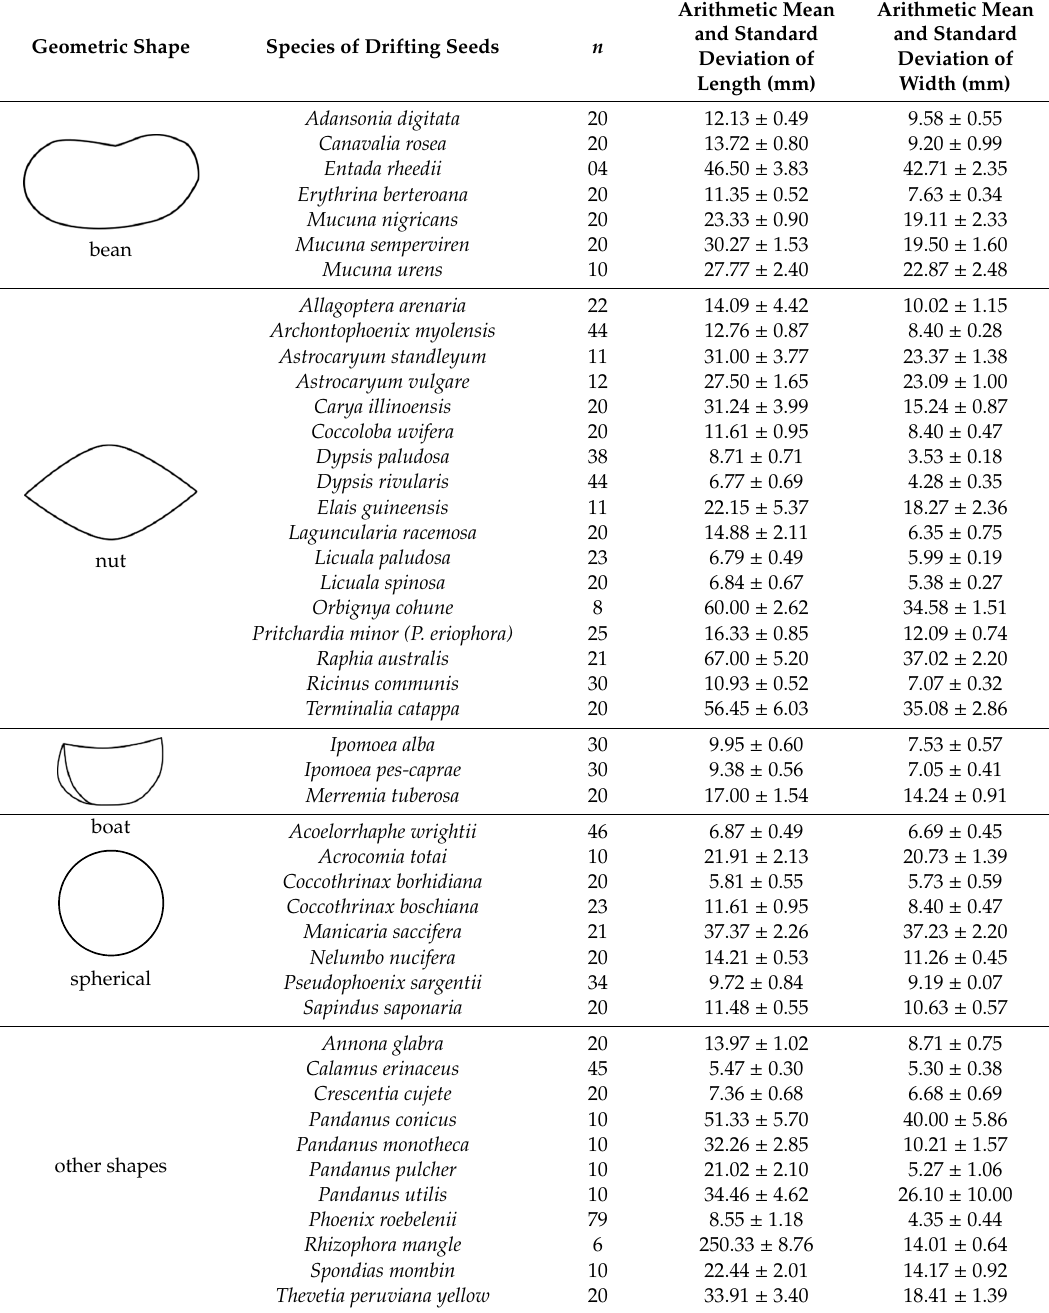
Table 2. List of morphological data and geometric shapes of the drifting seeds. Geometric Shape